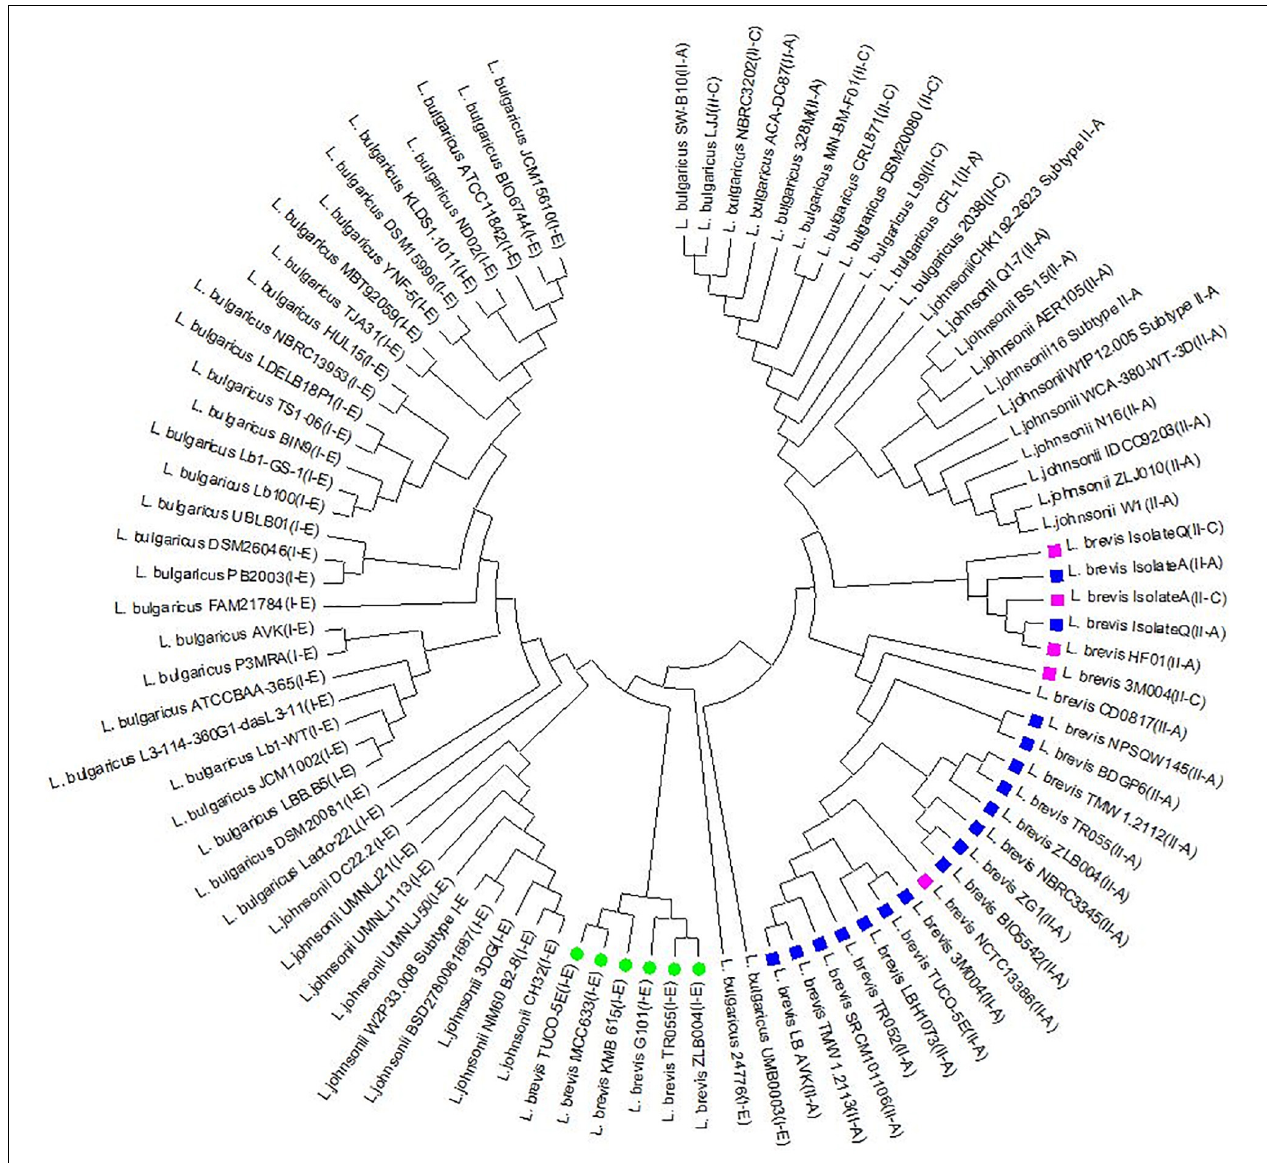
FIGURE 5 | Phylogeny tree based on Cas1 amino acid sequence in subtype II-A, II-C, and I-E related to L. brevis , L. johnsonii , and L. bulgaricus. Green circle, purple box, and blue box indicate the I-E, II-C, and II-A subtypes in L. brevis strains,